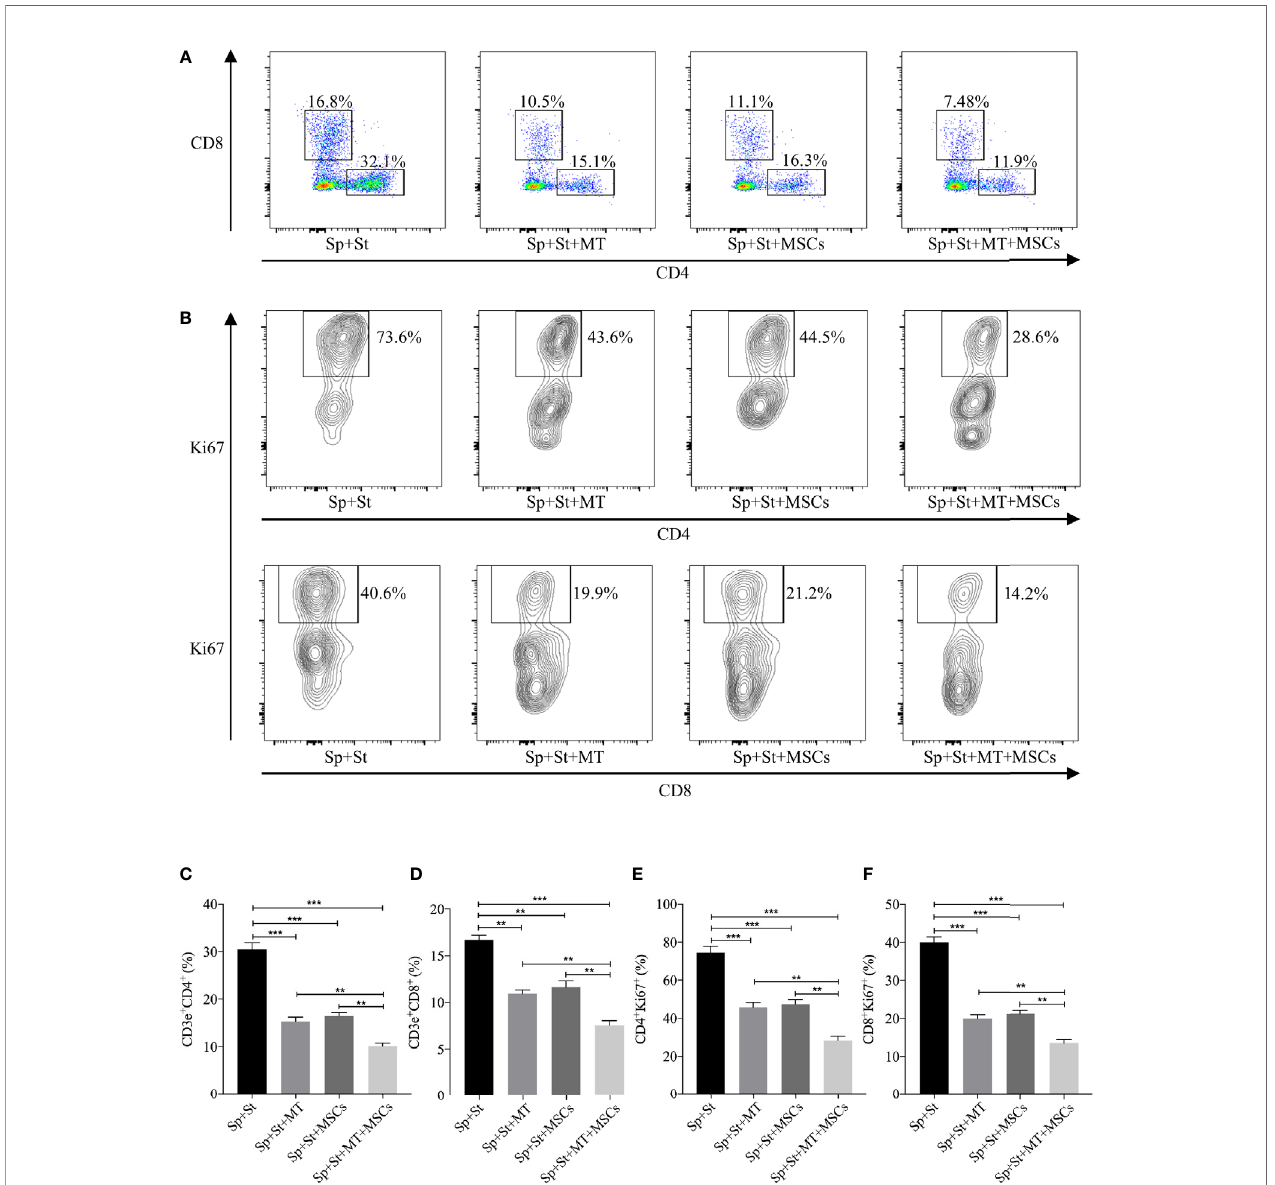
FIGURE 2 | MT either alone or combined with MSCs suppresses T cell proliferation in vitro . The splenocytes derived from B6 mice are co-cultured with MT, MSCs, and MT+MSCs respectively in the presence of the stimulators of anti-CD3 Abs, anti-CD28 Abs and IL-2 in vitro . (A) The pseudocolor of CD4 + and CD8 + T cells in vitro ; (B) Contour plot of CD4 + Ki67 + and CD8 + Ki67 + T cells in vitro ; (C) The percentage of CD4 + T cells; (D) The percentage of CD8 + T cells; (E) The percentage of CD4 + Ki67 + T cells; (F) The percentage of CD8 + Ki67 + T cells. Statistical analysis is performed by one-way analysis of variance (ANOVA), ** p <.01 and *** p <.001. Bar graphs represent mean ± SEM. MT, melatonin; MSCs, mesenchymal stromal cells; Sp, splenocytes; St, stimulators. The assay was conducted three times with three replicates each